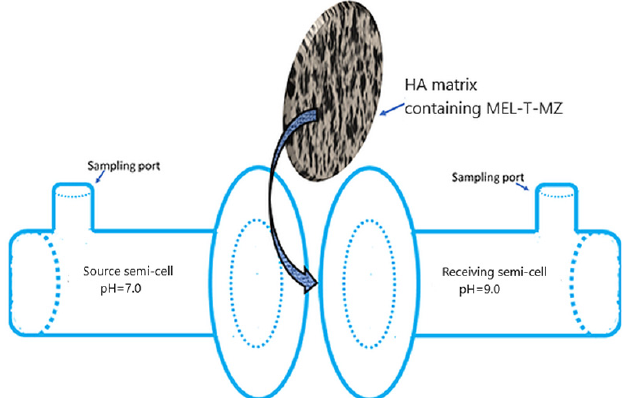
Figure 2. Homemade horizontal-flow diffusion